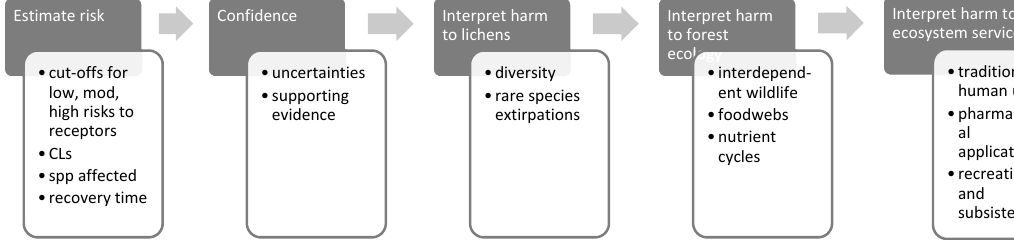
Figure 1. Process for assessing the ecological risk posed by the effects of air pollution on forest lichens used in this report.